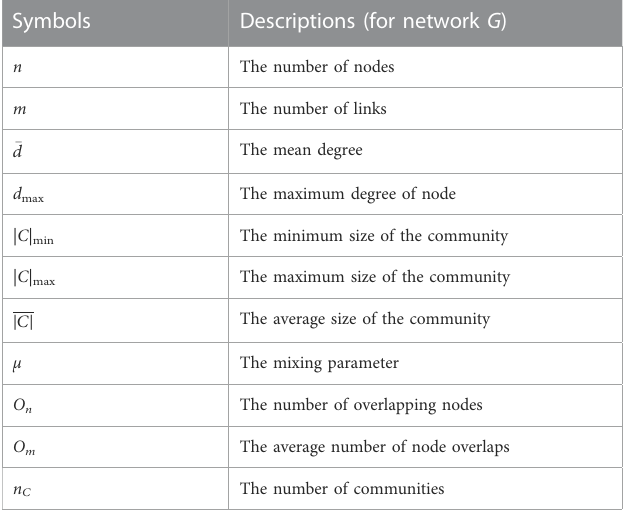
TABLE 3 Symbols and descriptions.